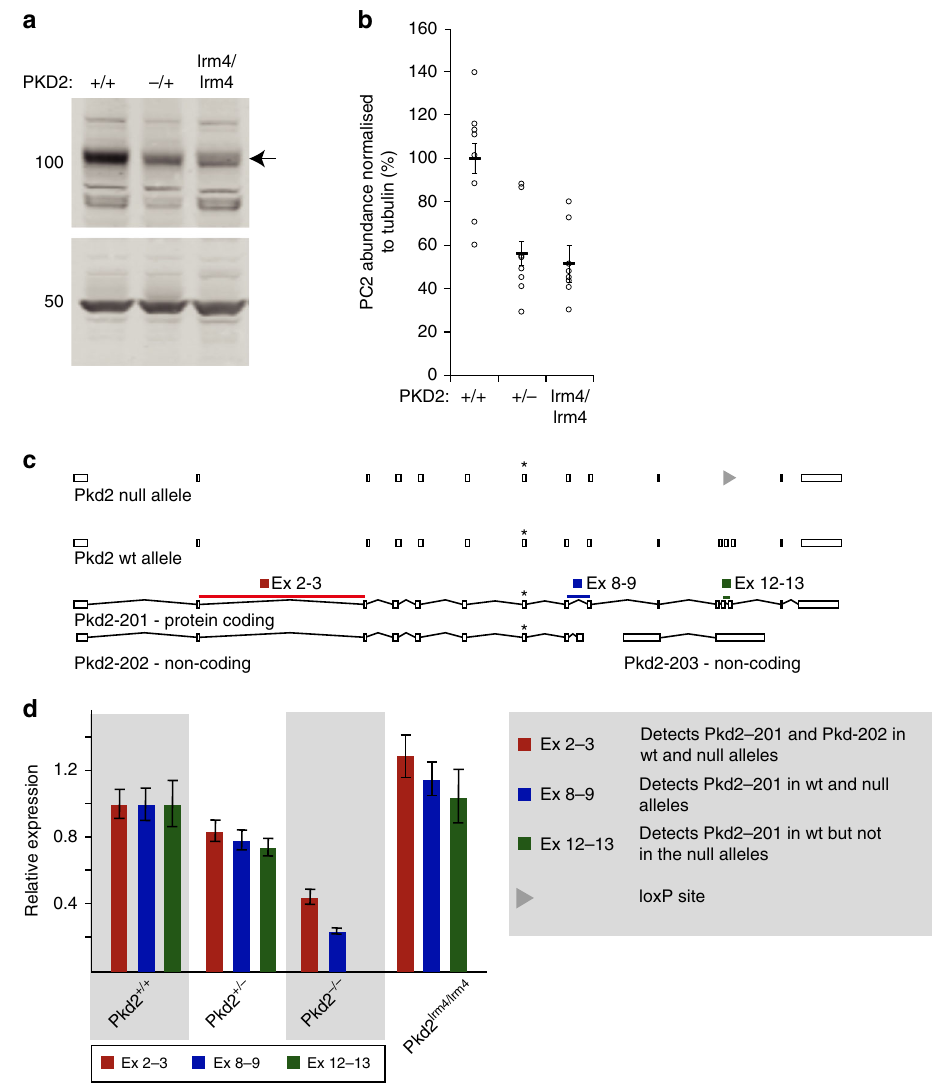
Fig. 2 Protein and RNA expression levels of PC2. a Western blots showing embryonic kidney lysates from E14.5 kidneys. The arrow indicates the PC2 band at ~110 KDa (the extra bands are due to non-speci fi c binding of antibody, see Supplementary Fig. 6). The fi nal lane represents Pkd2 lrm4/lrm4 kidney lysate. Tubulin loading control is shown at 50 KDa. b Graph represents protein levels normalised to tubulin loading control. Error bars represent SEM. n = 8 for each sample (pool of 3 kidney pairs). Pkd2 + / − ( − / + ) and Pkd2 lrm4/lrm4 (lrm4/lrm4) samples are reduced by 44.0% and 48.6%, respectively, compared to Wt ( + / + ). c Schematic of PC2 gene locus showing three transcripts predicted by ensembl. The positions of primers are indicated. The position of a loxP site that replaces exons 8 – 9 in the null allele is marked with a triangle and the position of the lrm4 point mutation is marked with an asterisk (*). d qPCR of RNA extracted from MEF cells reveals that PC2 transcription is not reduced in Pkd2 lrm4/lrm4 MEFs using primers covering three areas of Pkd2 ; Exons 2 – 3 (red), Exons 8 – 9 (blue), and Exons 12 – 13 (green) are the exons deleted in the null construct. Pkd2 + / + ( + / + ), Pkd2 + / − ( + / − ), Pkd2 − / − ( − / − ) and Pkd2 lrm4/lrm4 (lrm4) MEF cells were assessed. Two sets of MEFs for each genotype were analysed and a technical repeat was performed for each